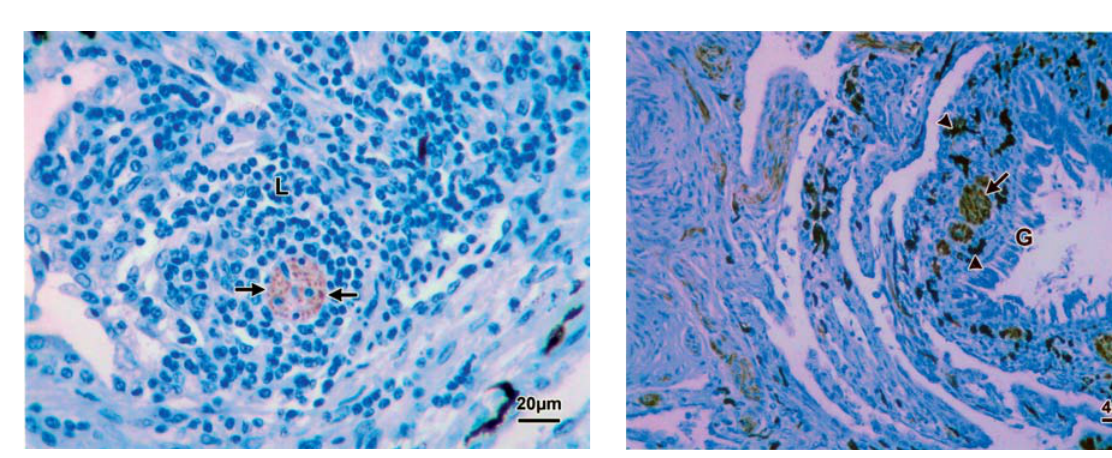
FIG. 5 PGP 9.5 immunopositive nerve fibres (arrows) in the upper limits of the cortex. Arrowheads: melanocytes. G: germinal epithelium